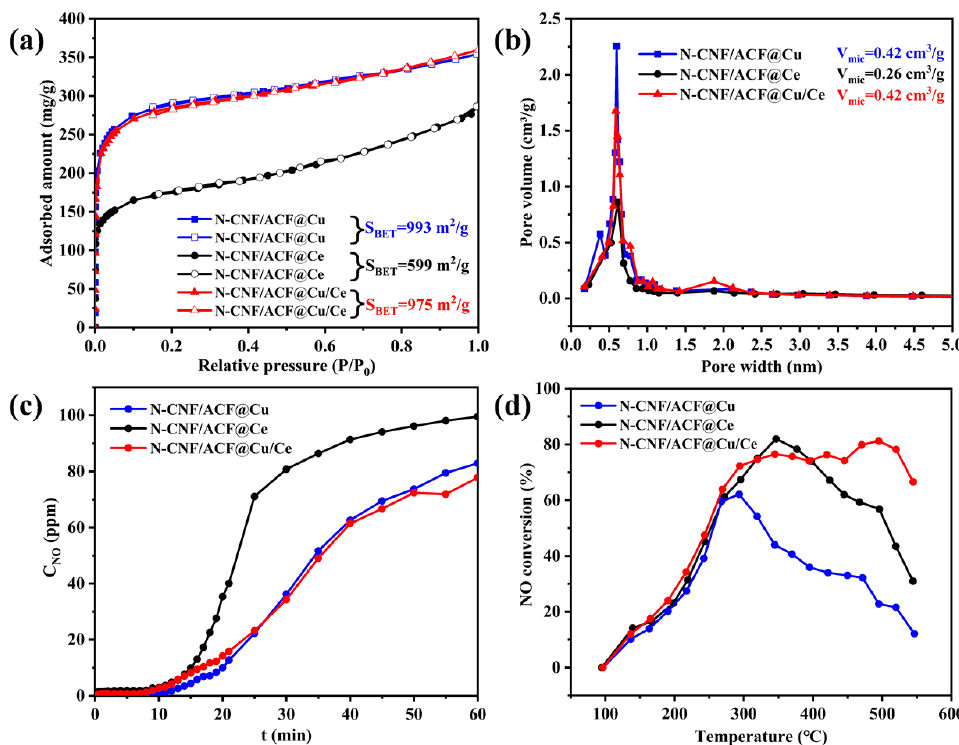
Figure 3. Nitrogen adsorption isotherms ( a ), pore size distributions ( b ), NO adsorption curves ( c ) and SCR reactivity curves ( d ) of N-CNF/ACF@Me.